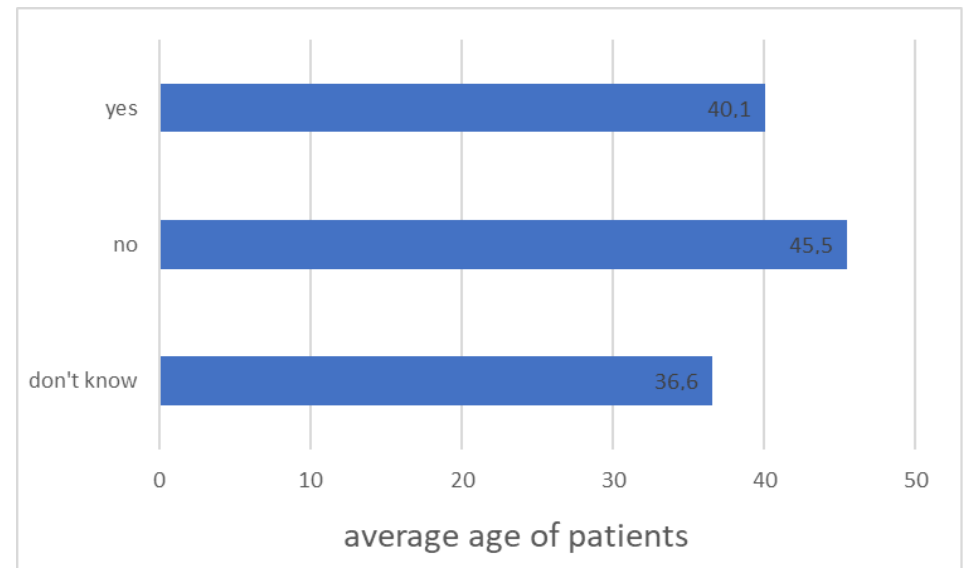
Figure 10. Average age of patients by their opinions on the education in the glucose meter use by a pharmacist ( n = 131, p < 0.001). Table 3. Patients’ interest in procedural instruction services—only statistically significant differences between